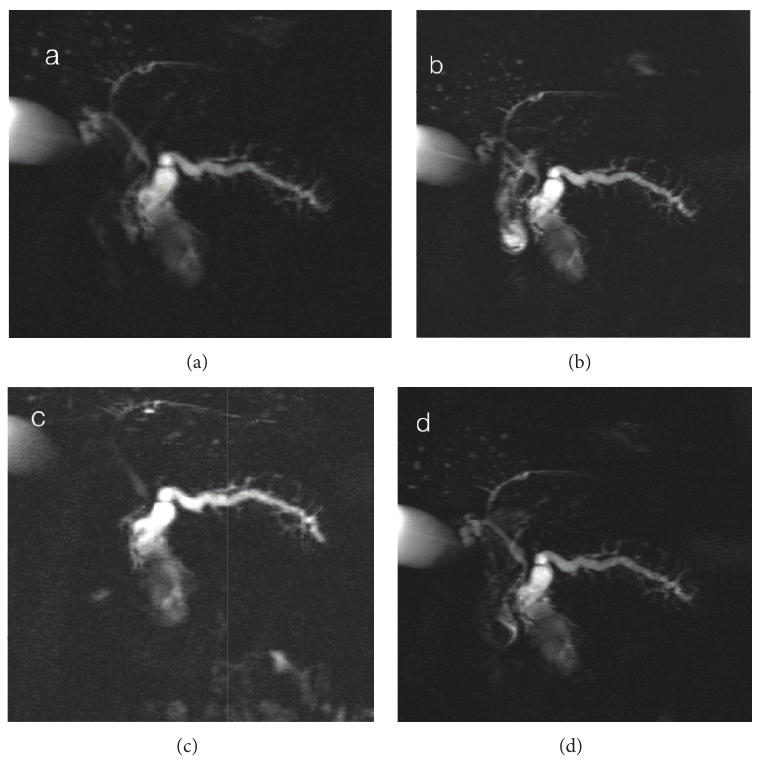
Figure 3: Single shot T2 WI before (a) and after ((b)-(c)-(d)) secretin stimulation show an increase of the signal intensity of the Wirsung duct of the cystic lesion; the communication of the lesion with the Wirsung duct is now clearly visible and is also possible to appreciate the signs of acinar depletion of the branch ducts.